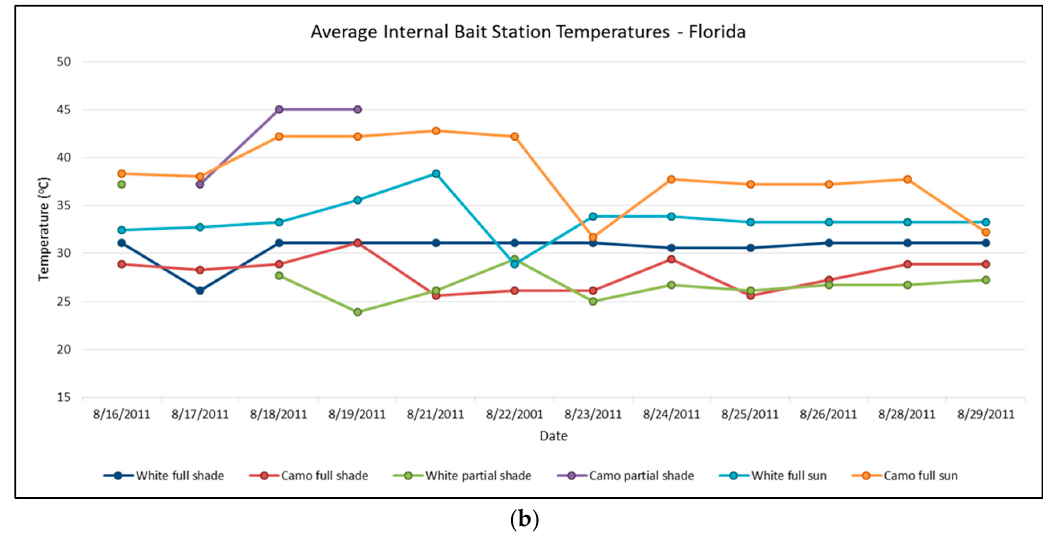
Figure 5. ( a ) Average internal bait station temperatures in Massachusetts. ( b ) Average internal bait station temperatures in Florida.